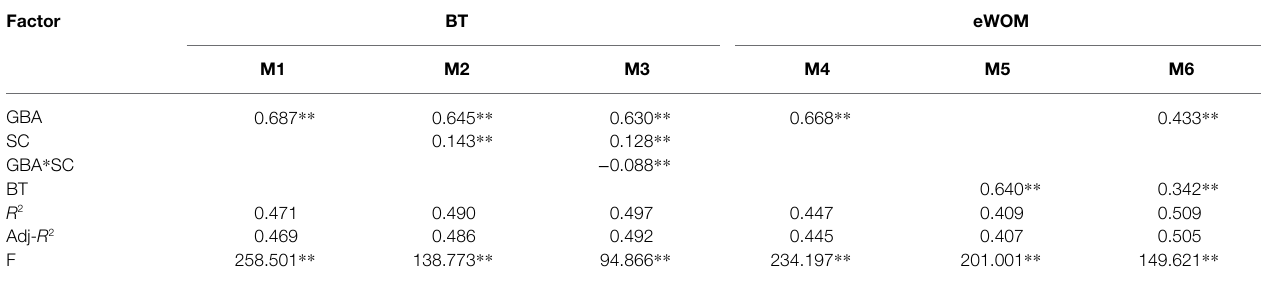
TABLE 4 | Model testing.